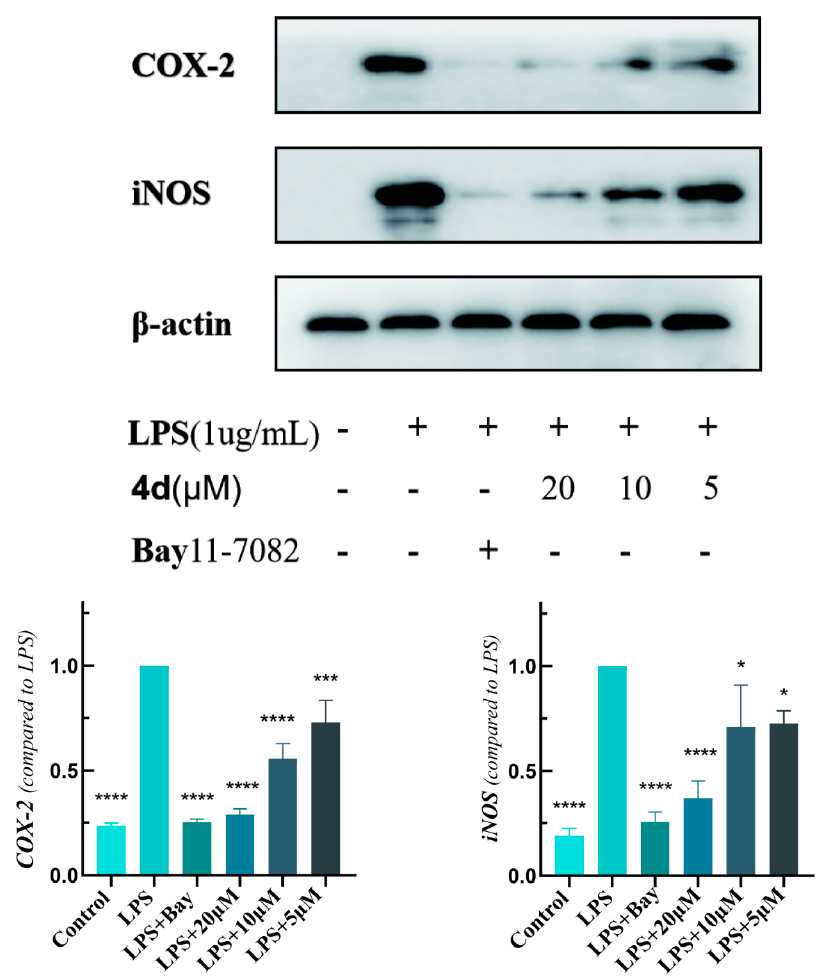
Figure 3. Compound 4d inhibited expression levels of COX-2 and iNOS in LPS-induced RAW264.7 cells. The results were presented as the means ± SD of three different experiments. The difference was considered statistically significant when p (*) < 0.05, p (***) < 0.001, p (****) < 0.0001.